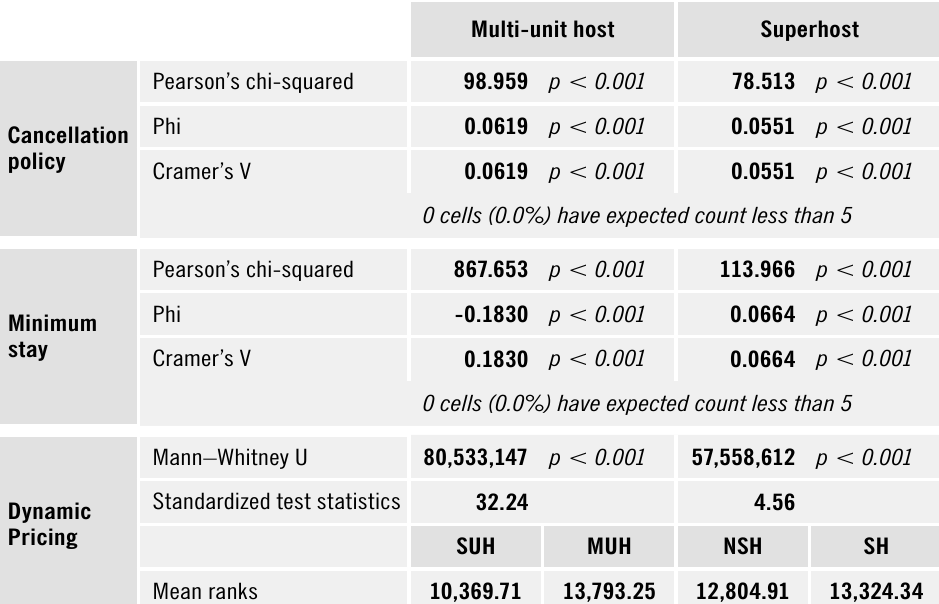
Multi-unit host